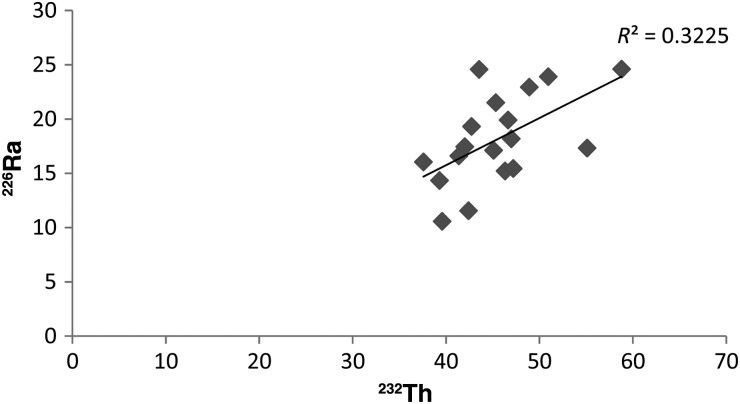
Correlation between 226Ra and 232Th radionuclides.